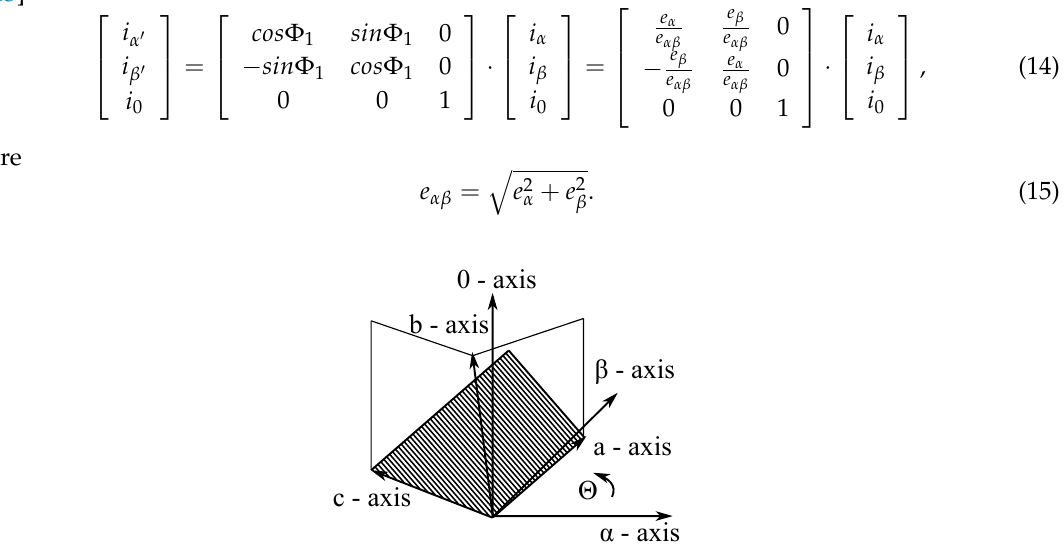
Figure 3. The physical importance of the coordinate transformation between a-b-c and α - β -0.